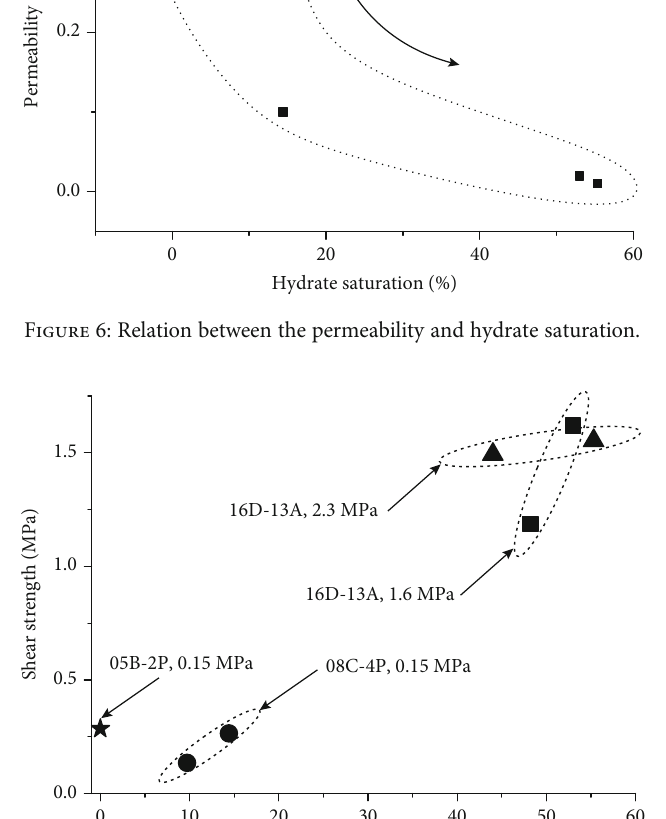
Hydrate saturation Figure 7: Relationship between the shear strength and hydrate